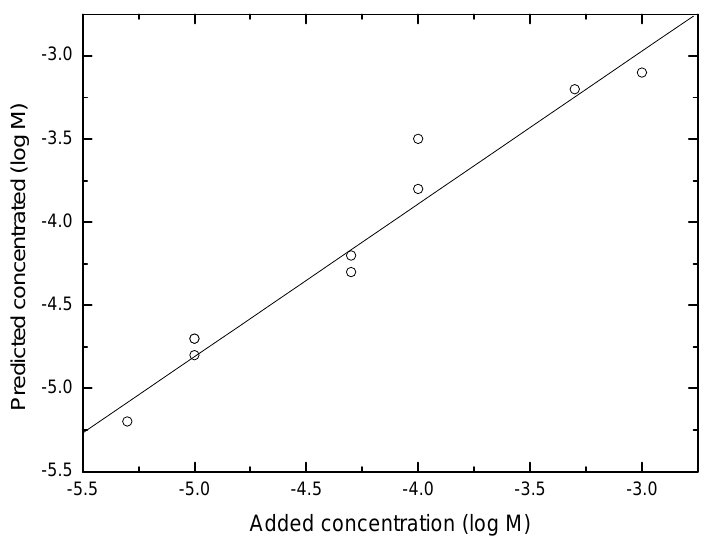
Figure 4. Calibration curve (18 samples) of ammonium from 5 × 10 -6 to 10 -3 M at pH 6. BPNN used 6, 3, 1 nodes. Concentration of n-butyrate was below 10 -4 M.